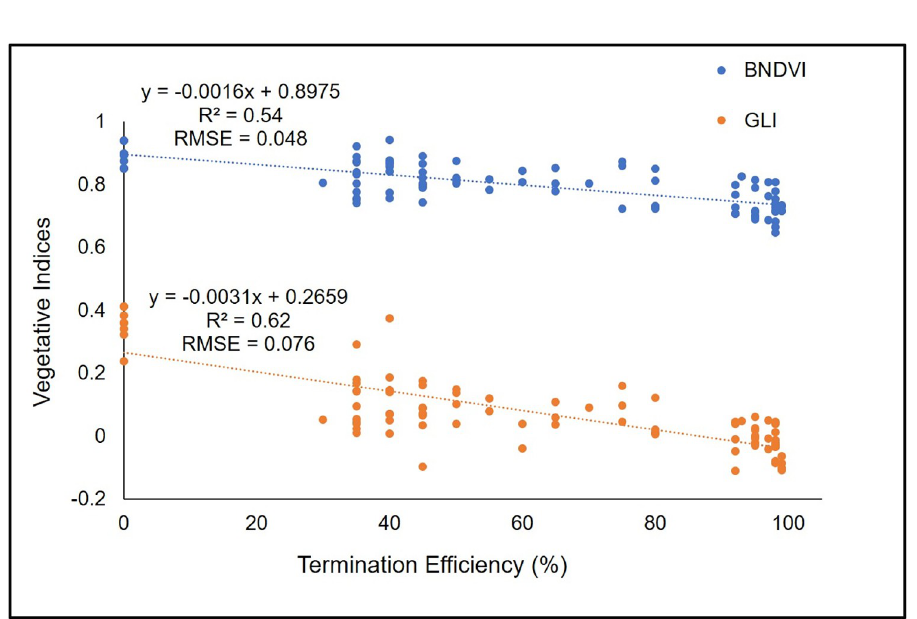
Fig 5. Scatter plot of Blue Normalized Difference Vegetation Index (BNDVI) and Green Leaf Index (GLI) response to termination efficiency (n = 88 for each vegetative indices) in wheat. R 2 = Coefficient of determination, RMSE = Root Mean Square